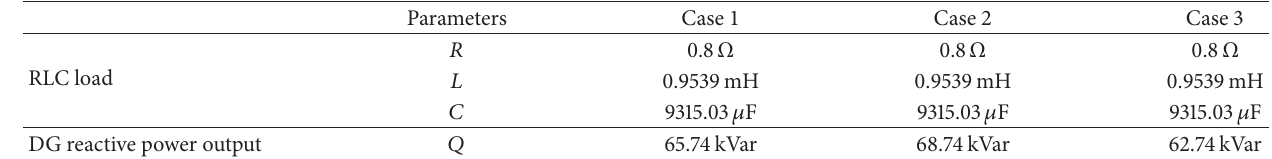
Figure 8: The PCC frequencies and reactive power output of the DG in the first scenario. Table 3: Parameters of the RLC load and DG reactive power output without the